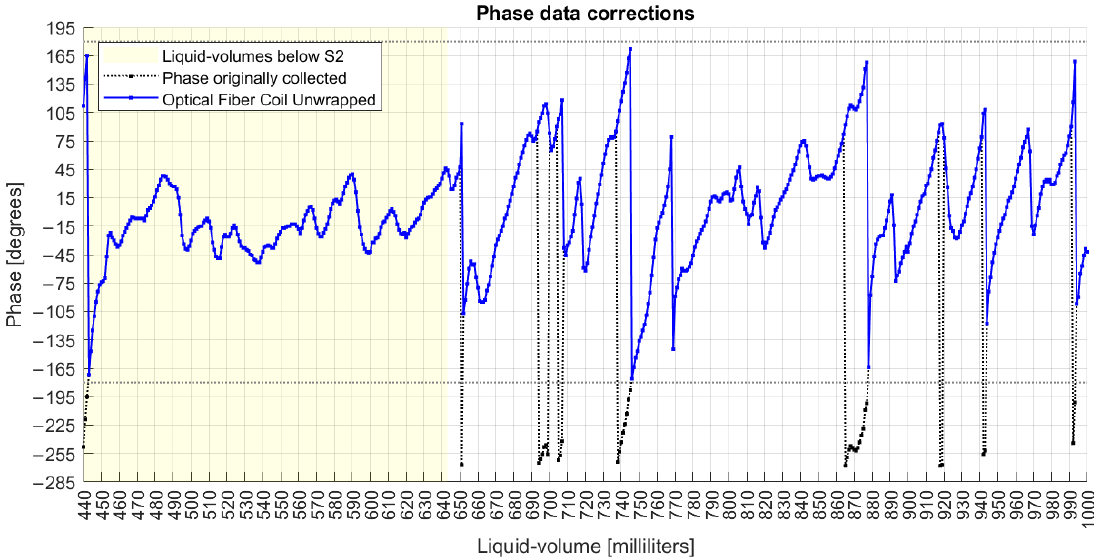
Figure 7. Phase measurand with correction of discontinuity jumps ≥ 180°.